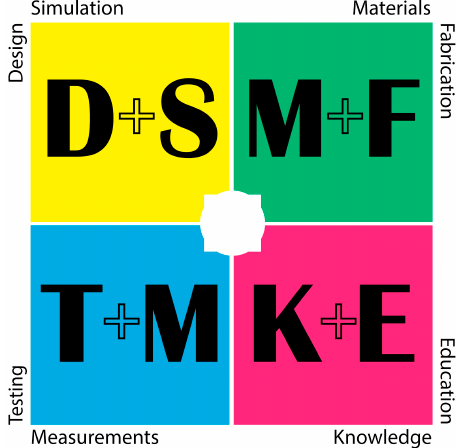
Figure 1. The four main themes of The Steel Bicycle Project (TSBP): (1) Design and simulation; (2) Materials and fabrication; (3) Testing and measurement; (4) Knowledge and